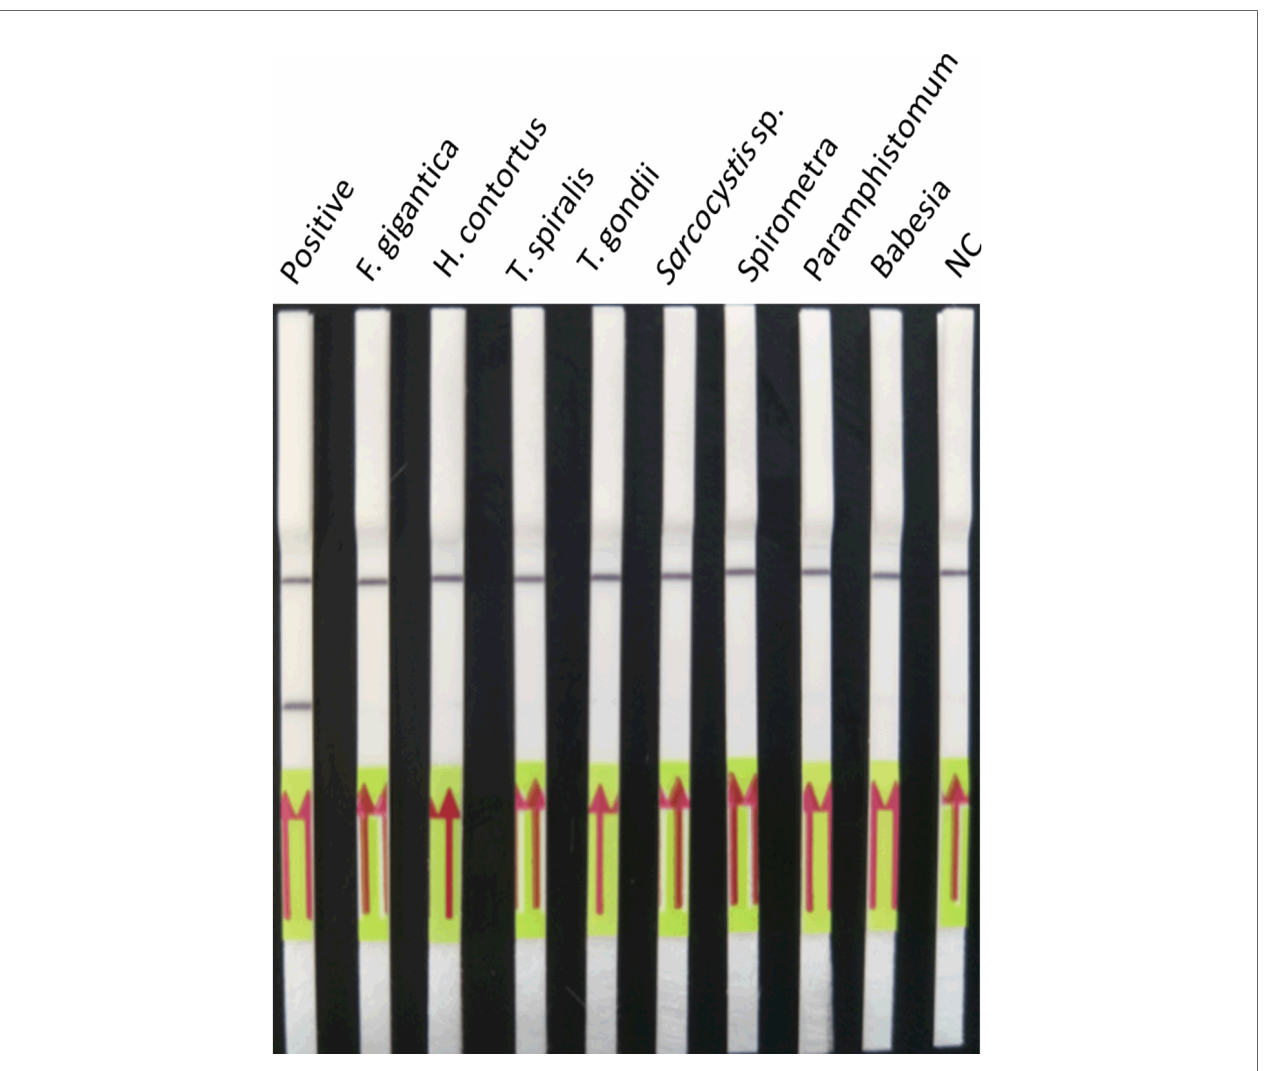
FIGURE 6 | Cross-reactivity of the LFD-RPA assay. The LFD-RPA assay detects S. japonicum exclusively and exhibits no cross-reactivity with genomic DNA from eight other parasites. Negative control (NC), DNA extracted from negative samples. The red arrows stand for the direction of reaction solution diffusing in the lateral fl ow